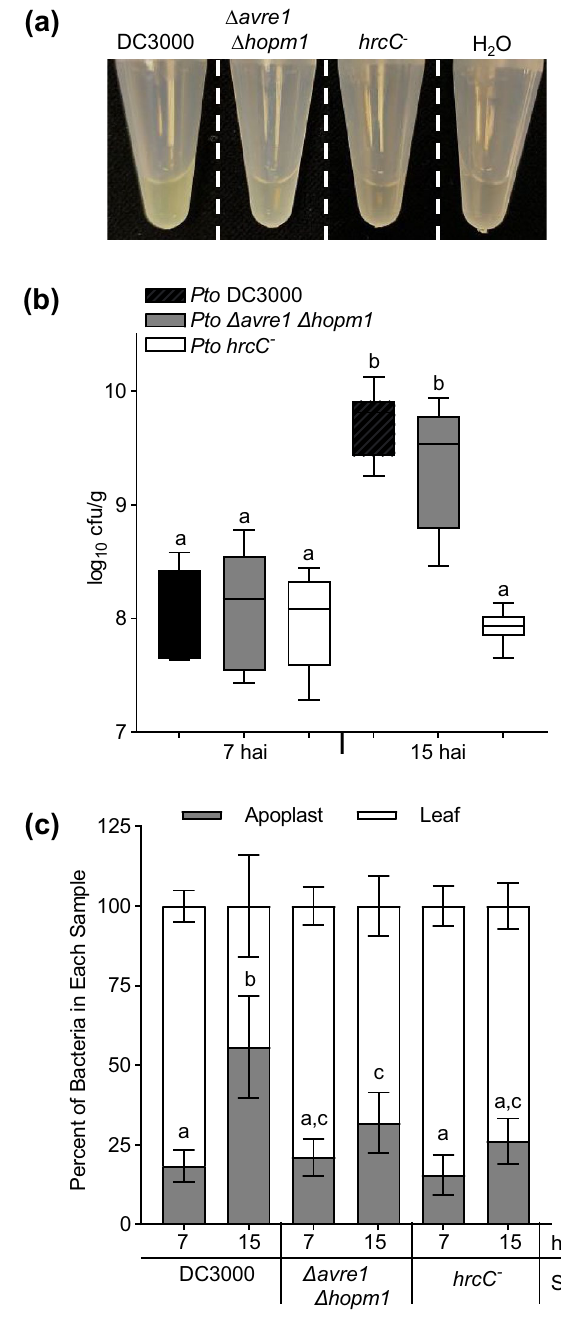
Figure 4. Determination of the efficiency of recovery of leaf-resident bacterial cells in apoplast fractions. ( a – c ) Three leaves of 5 week-old Arabidopsis plants were syringe-infiltrated with Pto DC3000, ∆avre1 ∆hopm1 or Pto hrcC − (at OD 600 = 0.2). ( a ) Apoplast fluid with bacteria extracted at 15 hai; note differing turbidity of samples. ( b ) Bacterial growth per tissue mass at 7 hai and 15 hai from combined measurement of bacteria in apoplast extracts and remaining in leaves. For each experiment, n = 3 samples/bacteria/time point, with each n consisting of 3 leaf discs taken from 3 different plants. The experiment was performed 3 times and combined data (n = 9) is shown. Boxes indicate the median and interquartile range and whiskers indicate minimum and maximum data distribution. ( c ) Distribution of bacteria between the apoplast and remaining leaf samples at 7 hai and 15 hai. For each experiment, n = 3 samples/fraction/bacteria/time point, with each n consisting of 3 different leaves from 3 different plants. The experiment was performed 3 times and combined data (n = 9) is shown. Error bars are standard deviations; different letters denote statistically significant difference between apoplast fractions based on ordinary one-way ANOVA with Tukey’s multiple comparisons test ( p <